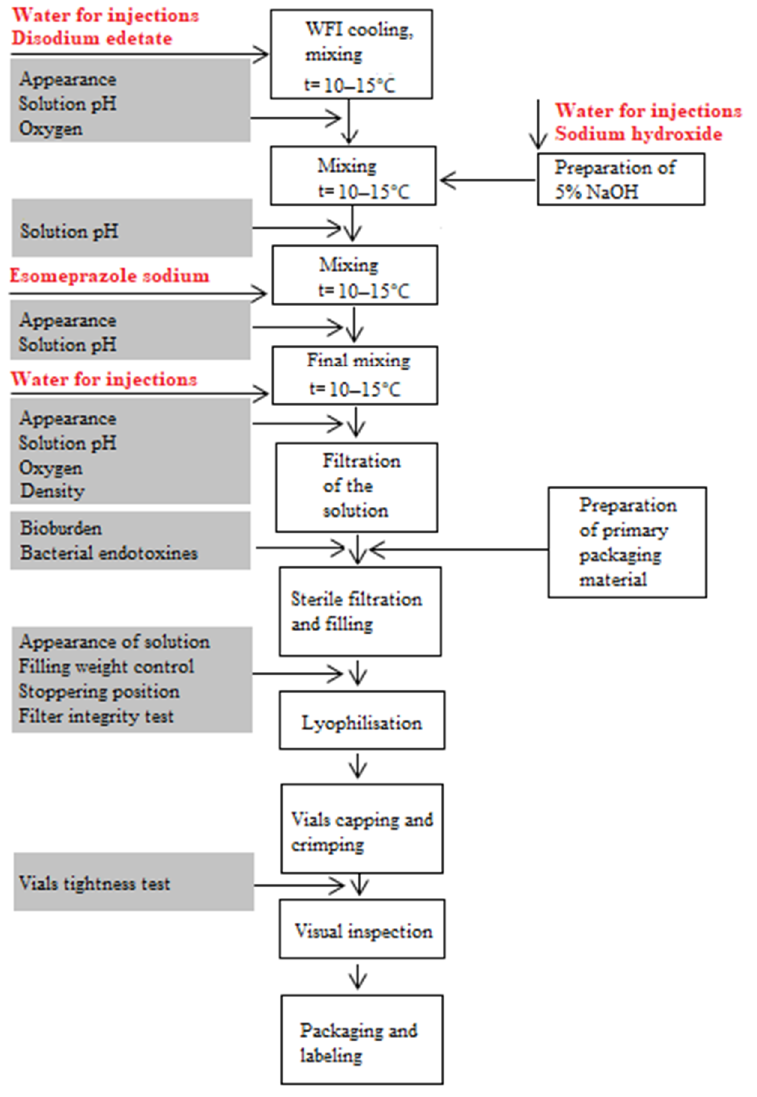
Figure 2. Flow chart of the manufacturing process of Esomeprazole 40 mg powder for solution for injection/ infusion. In the figure given, in red letters by the order of their addition all raw materials are presented, while details given in the white cells correspond to the description of production phases, and information in the grey cells corresponds to in-process control parameters.